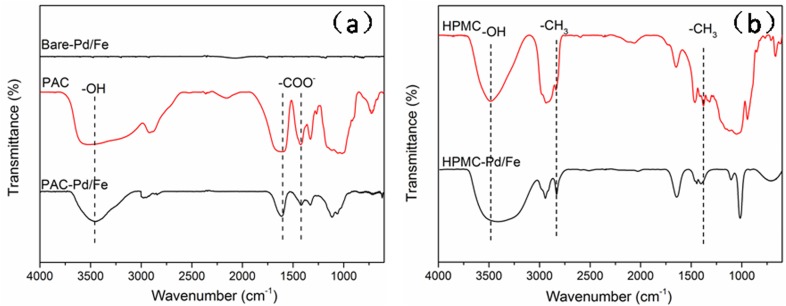
FTIR spectra of (a) PAC, bare-Pd/Fe and PAC- Pd/Fe NPs; (b) HPMC, HPMC-Pd/Fe NPs. Fe loading is 0.4 g L-1 with Pd 0.3 wt% of Fe, cellulose is 1 g L-1.